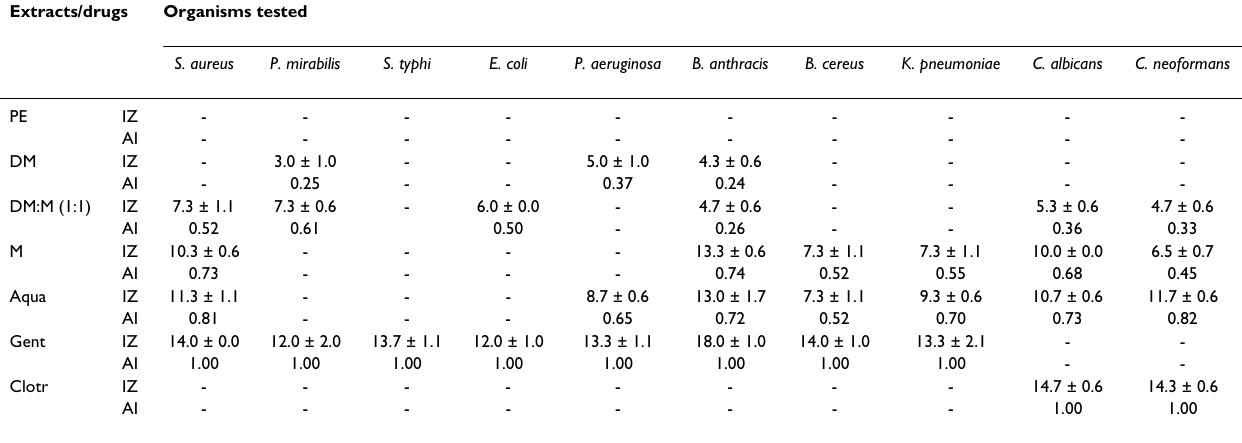
Table 1: Antimicrobial activity of T. brownii stem bark extracts Extracts/drugs Organisms